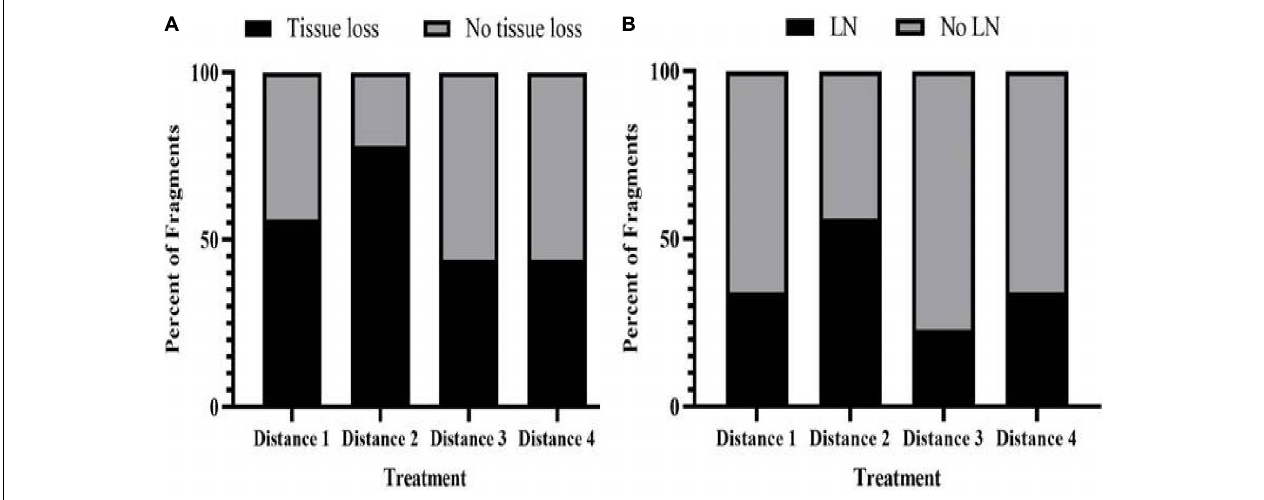
FIGURE 8 | Comparison of disease induction in O. faveolata recipient fragments touching different M. cavernosa donors (D1, n = 18; D2, n = 9; D3, n = 9; D4, n = 9). (A) Percent of touching O. faveolata recipient fragments showing gross signs of tissue loss when in contact with different donor treatment fragments. (B) Percent of touching O. faveolata recipient fragments showing a histopathological parameter, lytic necrosis (LN) when in contact with different donor treatment